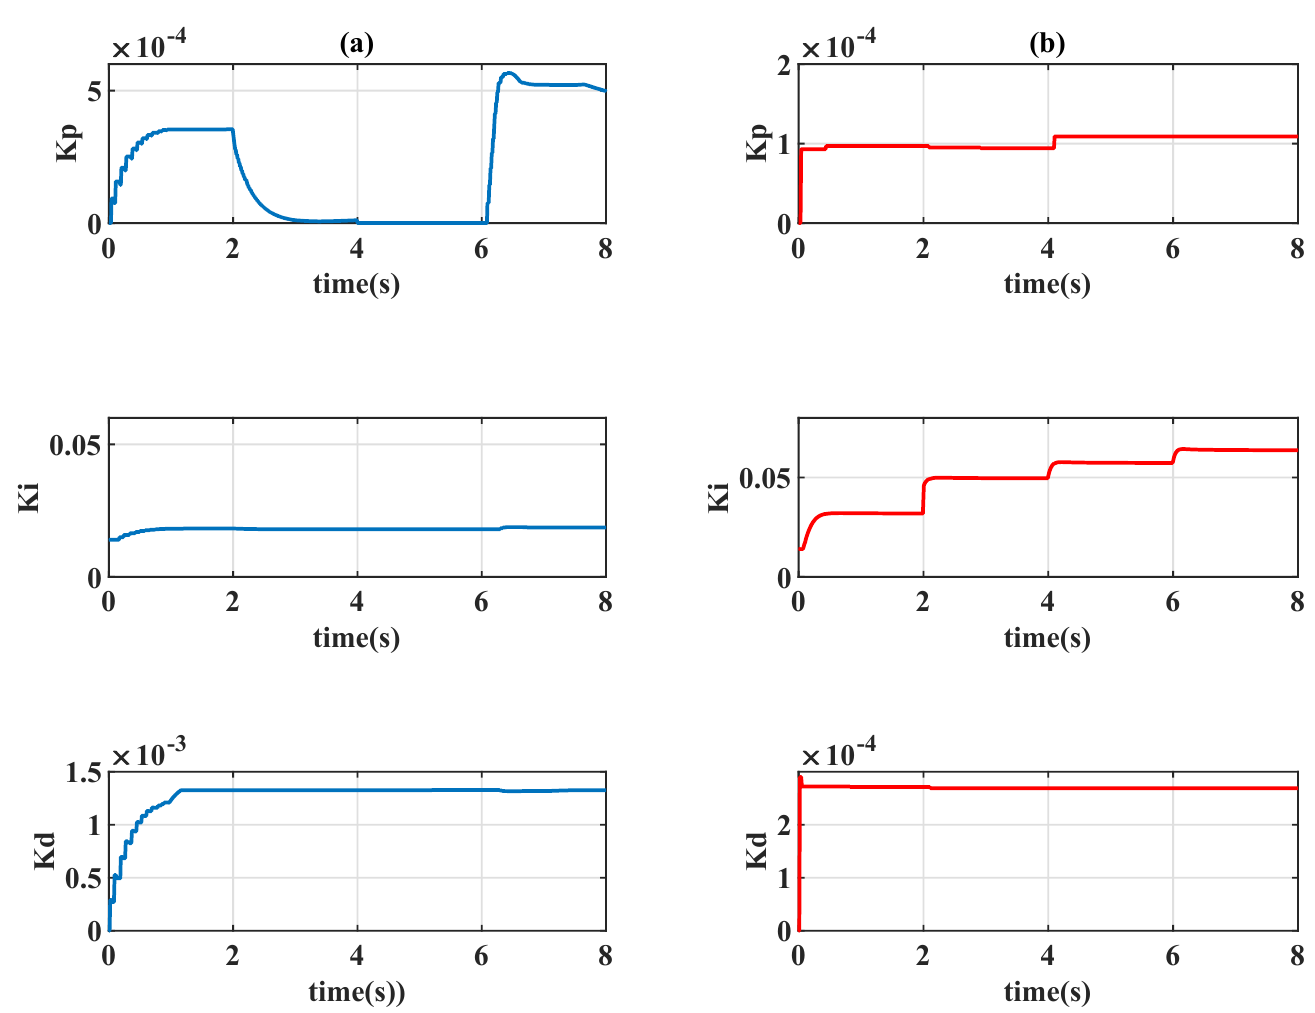
( z ) and ( b ) Sarsa C e Q